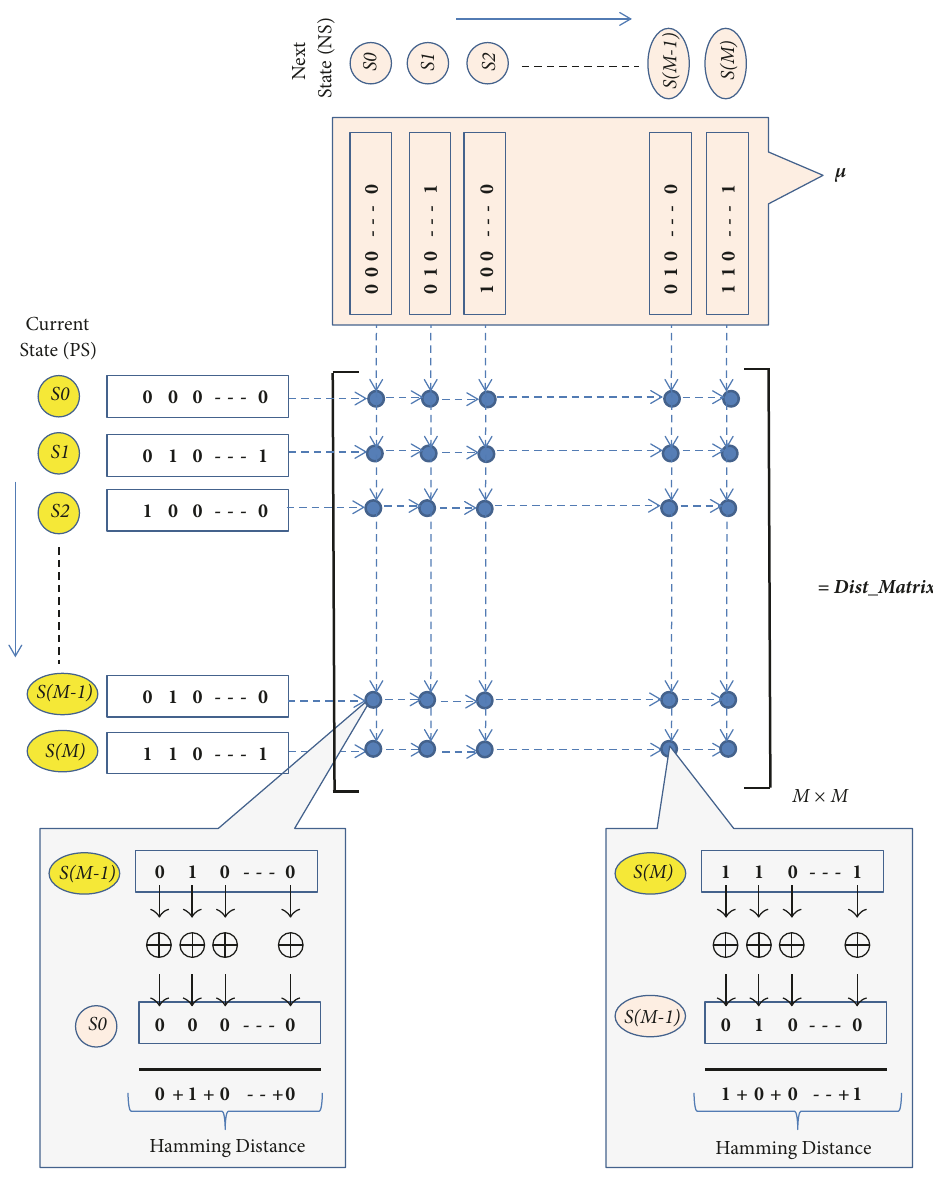
Figure 2: Formation of 𝐷𝑖𝑠𝑡 𝑀𝑎𝑡𝑟𝑖𝑥 by calculating the Hamming distance between particular nodes (i.e., states).